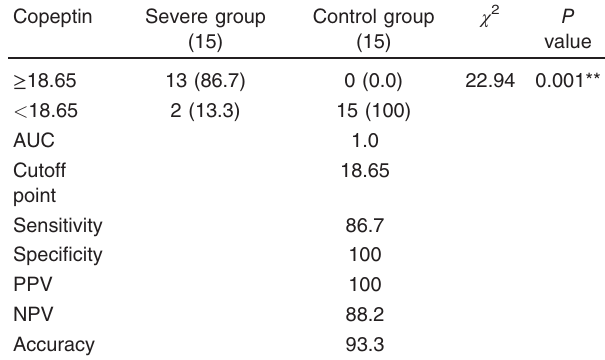
AUC, and area under the curve; NPV, negative predictive value; PPV, positive predictive value. **Highly